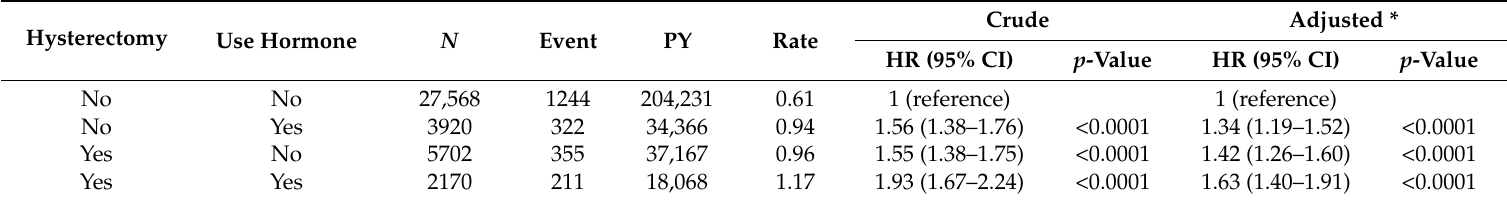
Table 4. Risk of depression in women among joint hysterectomy and hormone therapy.